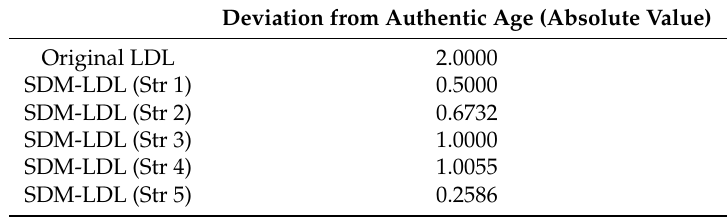
Table 3. The comparison of deviations from authentic age based on the example of Table 1.